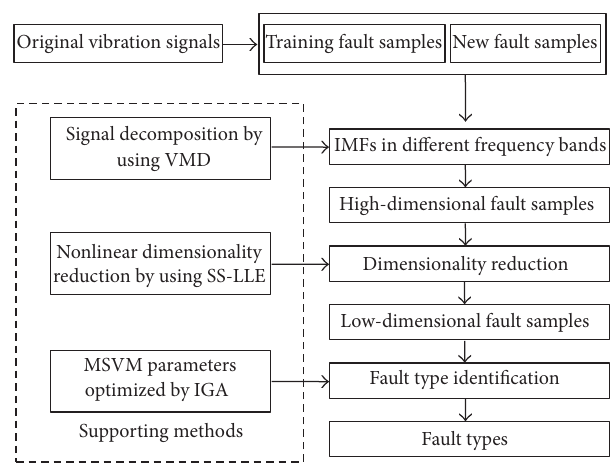
Figure 3: The process of fault diagnosis based on VMD and IGA-MSVM.